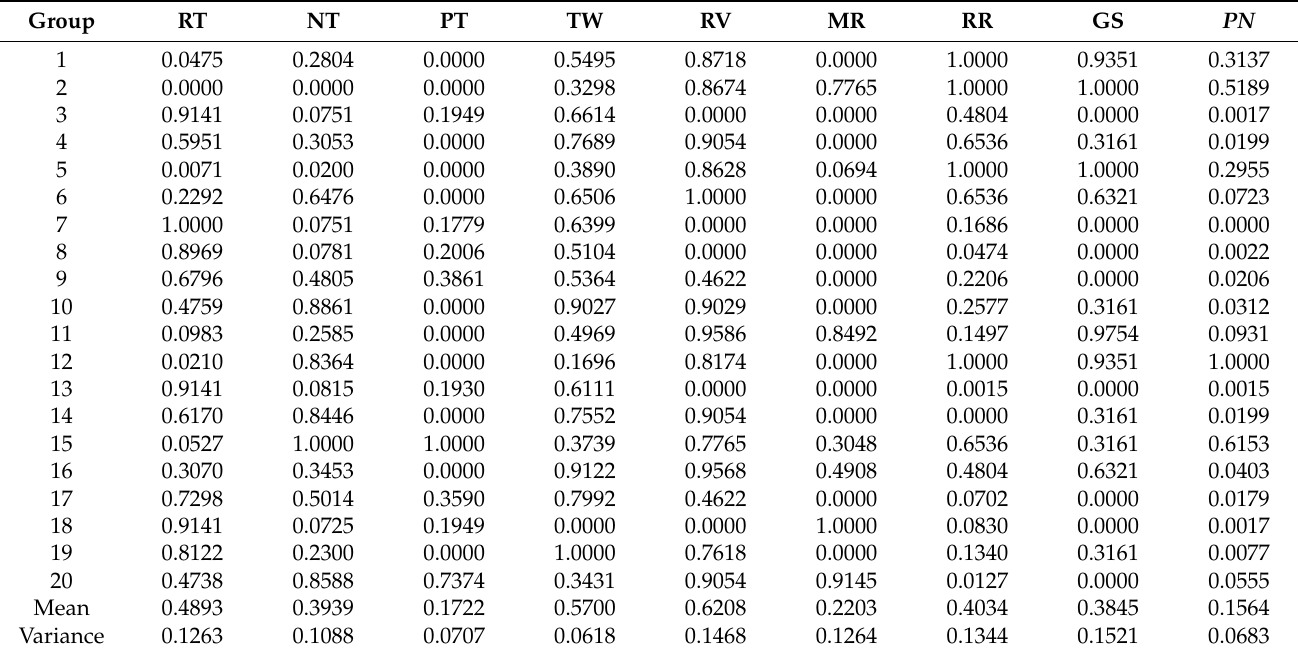
Table 8. Collusive Group